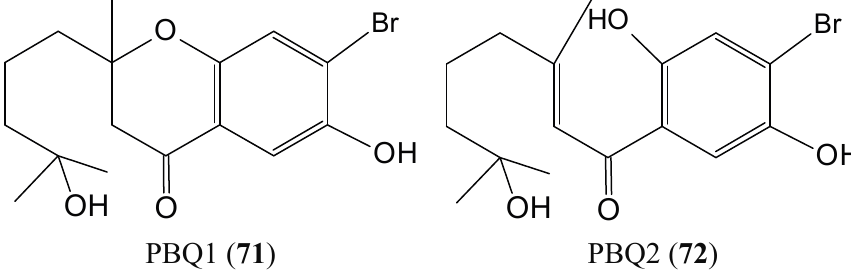
Figure 28. 7-Hydroxycymopochromanone (PBQ1, 71 ) and 7-hydroxycymopolone (PBQ2, 72